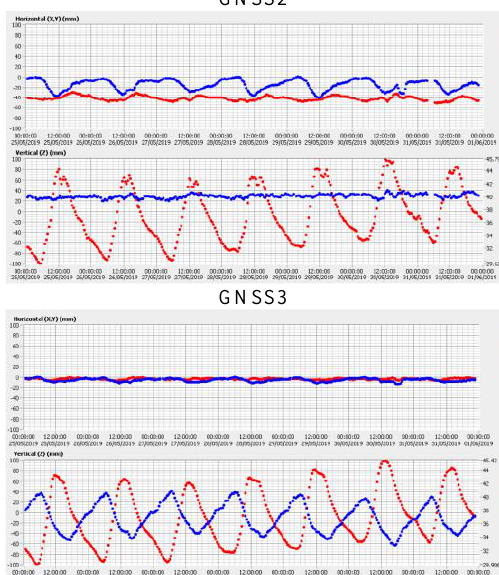
Figure 8. Daily displacements and temperatures on north pylon (GNSS2) and mid-span